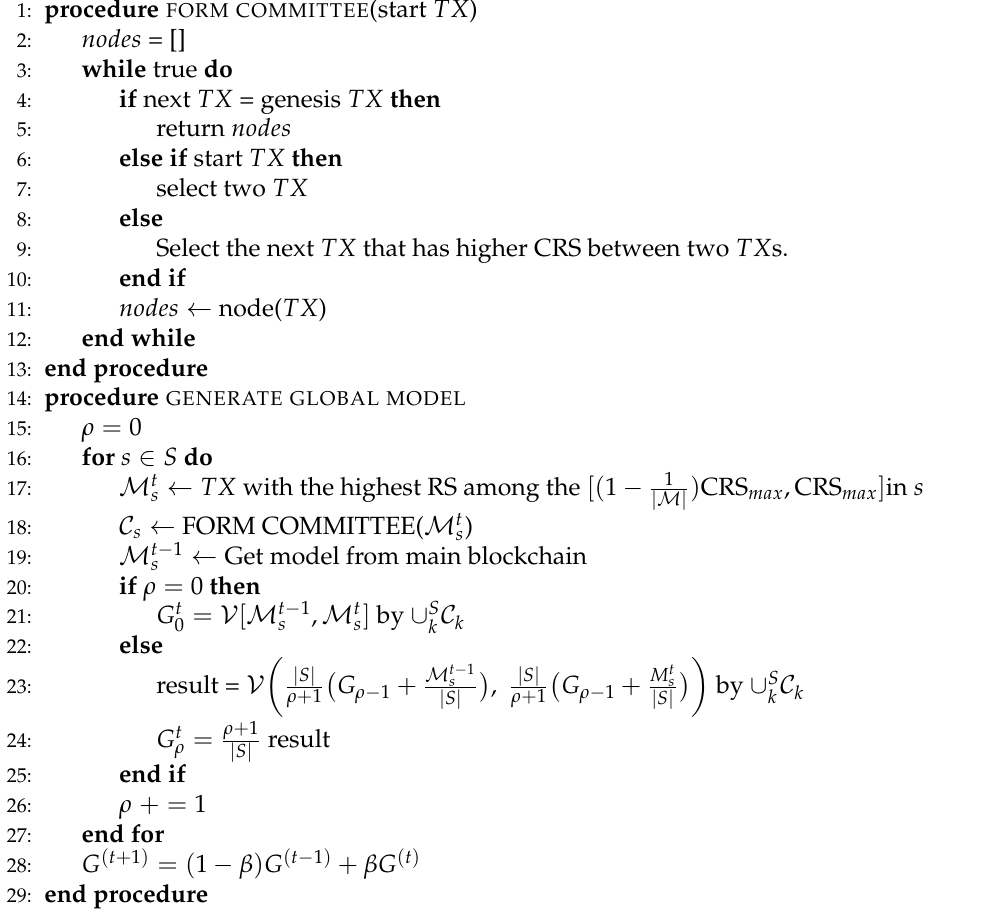
Algorithm 3 Global model aggregation